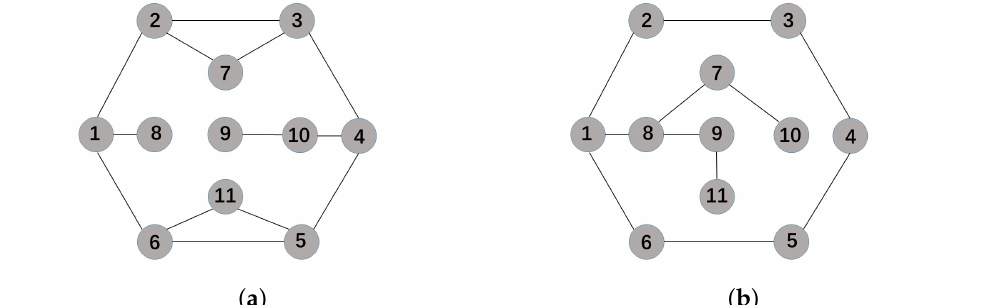
Figure 1. ( a ) Network associated with the adjacency matrix A; ( b ) network associated with the adjacency matrix